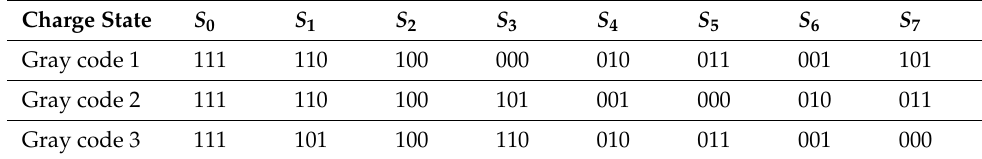
Table 1. Possible Gray code bit-labeling for a TLC flash cell.